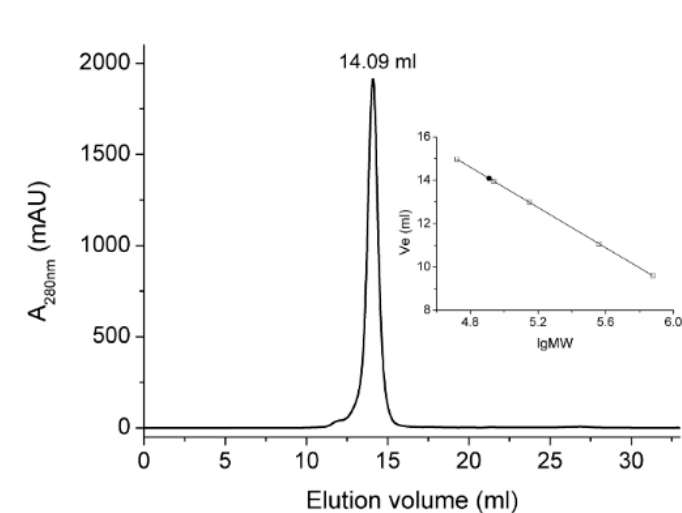
Figure 4. Overexpression and molecular mass determination of Bl IDH. ( A ) SDS-PAGE analysis. M, molecular mass marker; lane 1, crude extract from cells transformed by pET-28b(+) with IPTG treatment; lane 2, crude extract from cells transformed by recombinant plasmid pET- Bl IDH with IPTG treatment; lane 3, purified Bl IDH; ( B ) Western blot analysis. Lane 1, purified Bl IDH; lane2, negative control, crude extract from cells transformed by pET-28b(+) with IPTG treatment; ( C ) Size exclusion chromatography (SEC) analysis of Bl IDH.